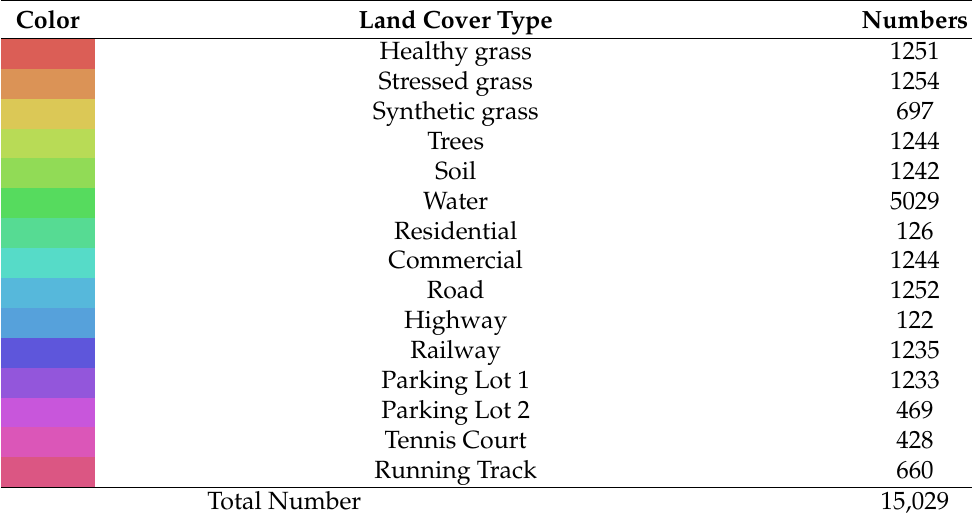
Table 4. background color and number of land cover classes on